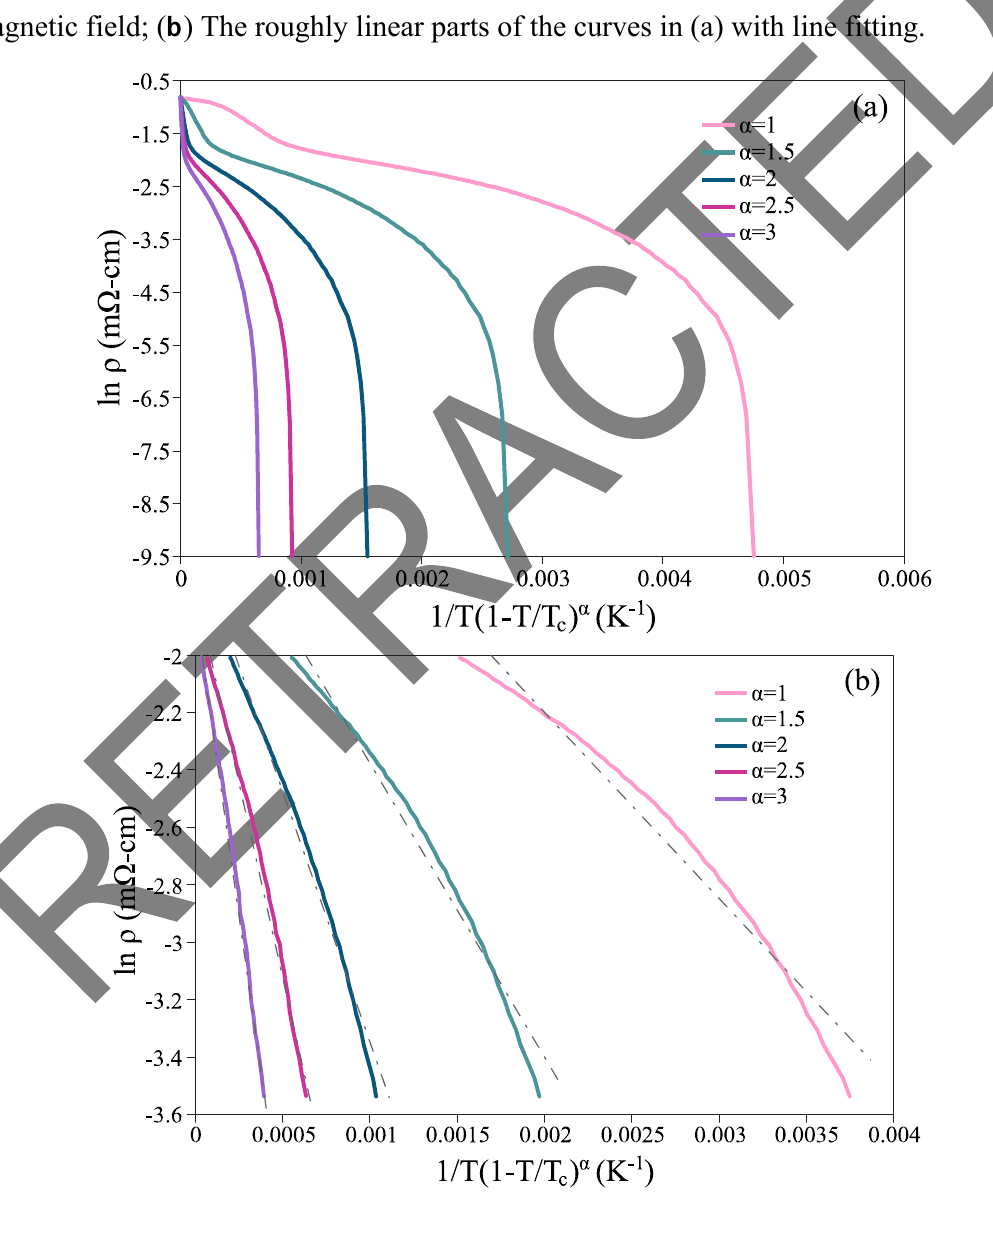
Figure 3. ( a ) The curves of ln ρ versus 1/T(1 − T/T